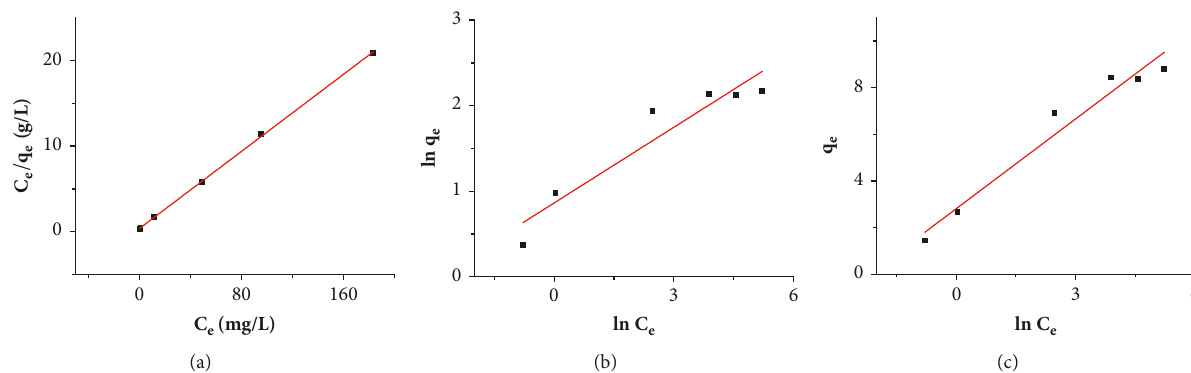
Figure 4: (a) Langmuir, (b) Freundlich, and (c) Temkin isotherms for the adsorption of Mg 2+ ions onto CTNTs scaffolds as measured at pH 7.2.